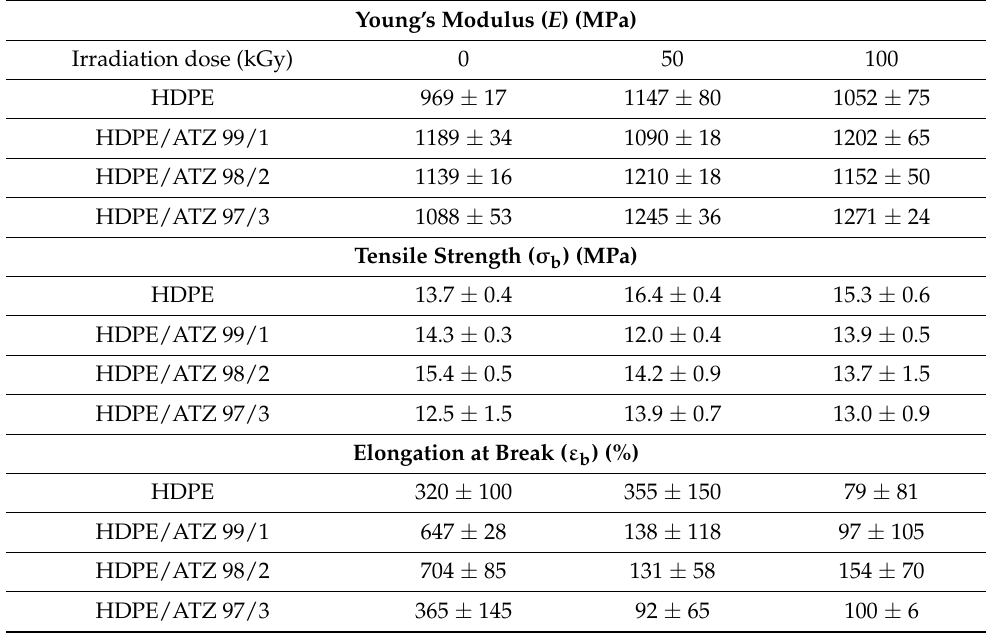
Table 2. Young’s modulus (E), tensile strength at break ( σ b ), and elongation at break ( ε b ) of irradiated composites obtained by stress–strain experiments, performed at room temperature. Data of untreated HDPE and composites [18] are reported for